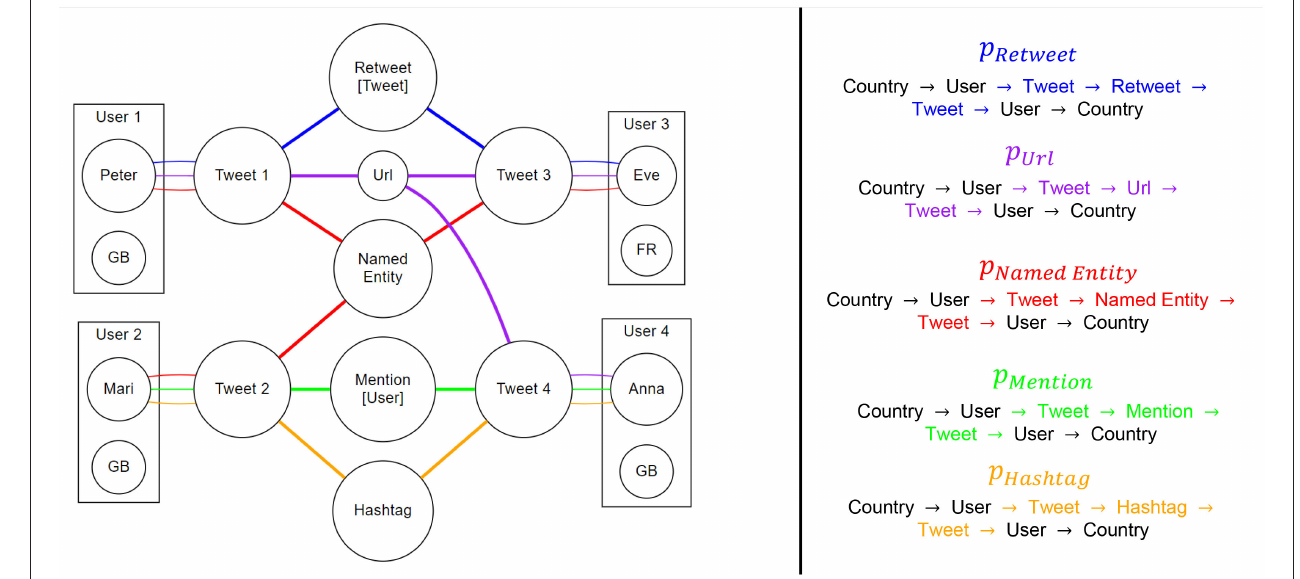
FIGURE 1 | Structure of considered connections and corresponding meta paths for each type. National meta paths are constituted via connections between users from the same country, e.g., for p Hashtag from Mari to Anna (both located in Great Britain) and for p Named Entity from Peter to Mari. Transnational paths are e.g., p Url from Peter to Eve (from Great Britain to